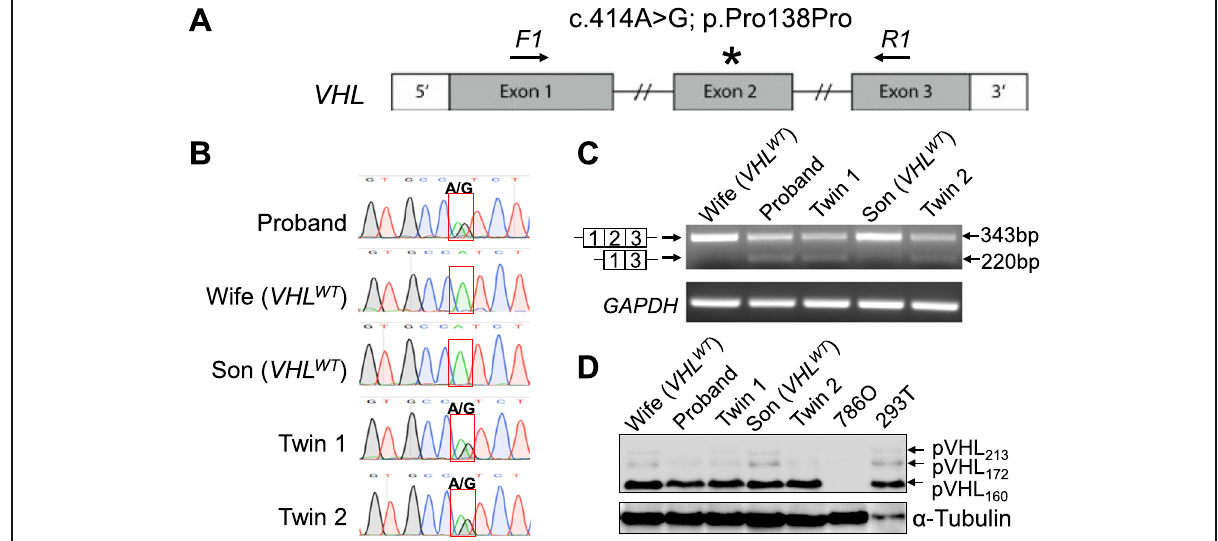
Fig. 2 Genetic and expression analysis of synonymous mutations c.414A > G using primary fibroblasts. ( a) Schematic of the exon structures of human VHL gene with the positions of the mutation and two RT-PCR primers indicated. ( b ) Chromatogram tracks showing the DNA sequence near the mutation site for each of the five fibroblast cell lines established from the patient family. ( c ) RT-PCR bands amplified from the cDNA of E1E2E3 and E1E3 transcripts using mRNA extracted from fibroblast cells. GAPDH was used as an internal control. ( d ) Western blot showing the three pVHL isoforms in the five fibroblast cell lines. RCC cell line 786O (VHL-null) and HEK293T (VHL-intact) were used as control for pVHL detection. α -Tubulin was used as loading control. VHL antibody is from Cell Signaling